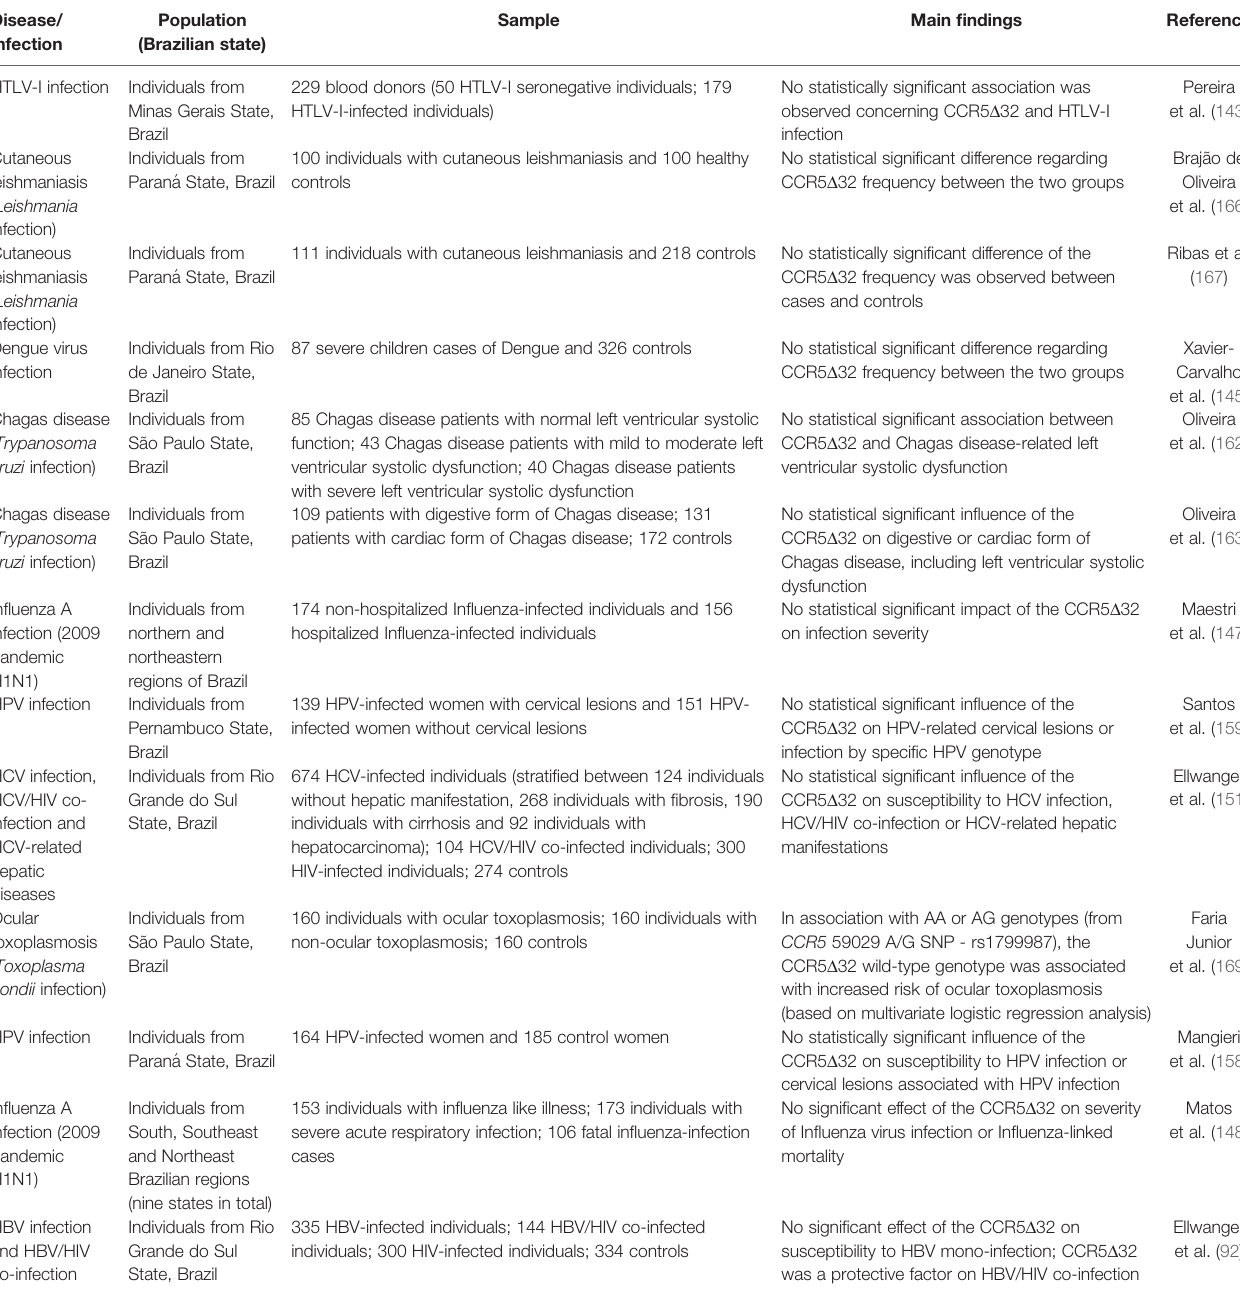
TABLE 2 | Impacts of the CCR5 D 32 on infectious diseases. Disease/ Population Infection (Brazilian state)